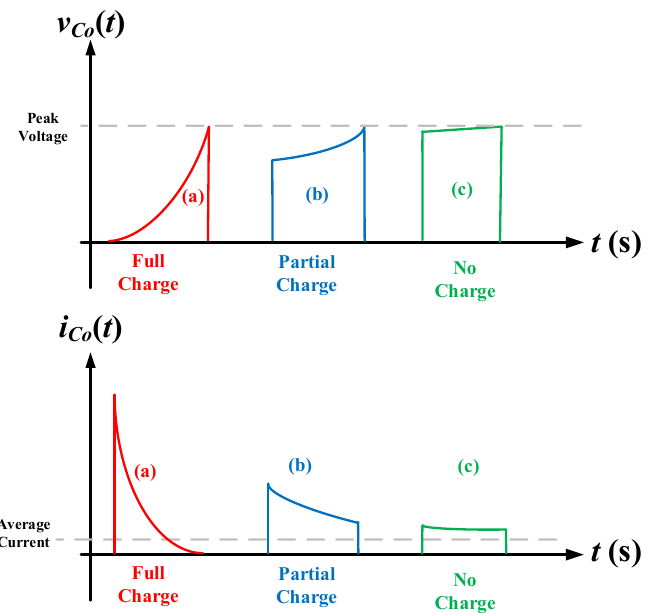
Figure 19. Capacitor charging modes: ( a ) full charge, ( b ) partial charge, ( c ) no charge. The three modes of operation are defined In general, the equivalent resistance of the circuit represented in Figure 18 can be defined by Equation (11) [118]: